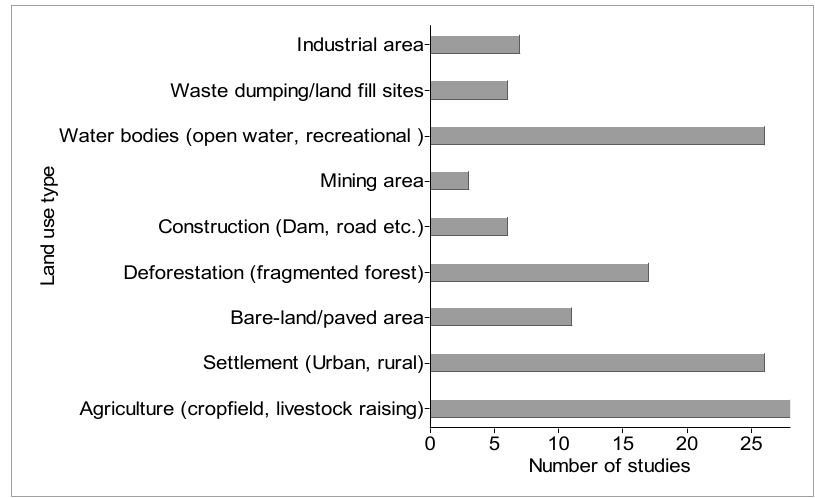
Figure 5. The general classification of land use and land cover.